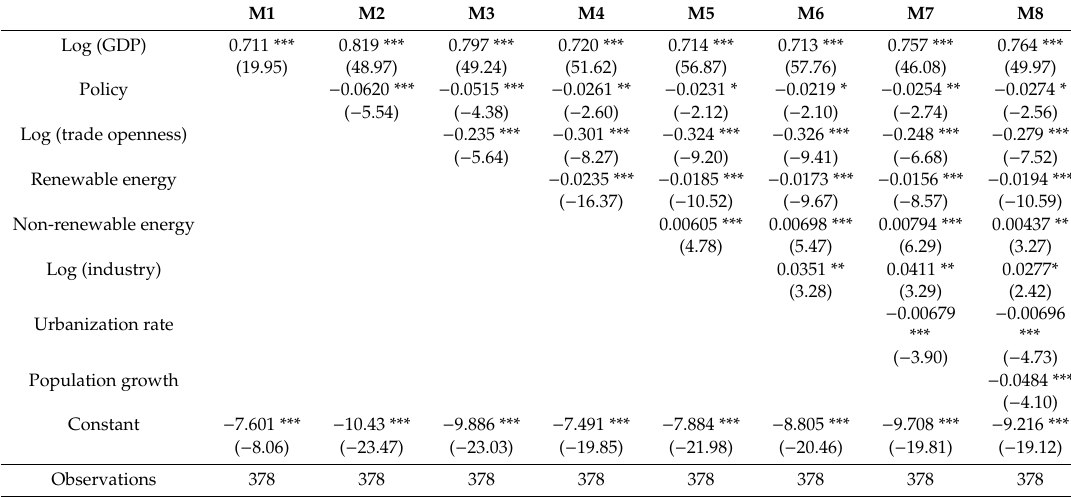
Table 5. Relationship between CO 2 emissions and GDP, with control variables at the European Union (EU)